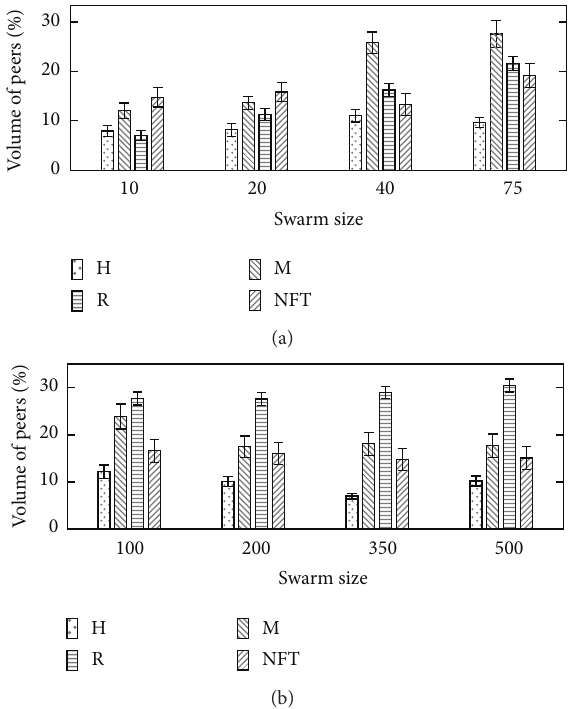
Figure 14: Peers suffering data loss in case of an ISP gateway-link